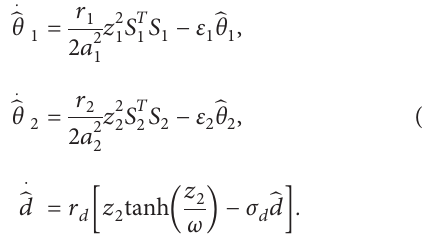
Figure 2: The tracking error z